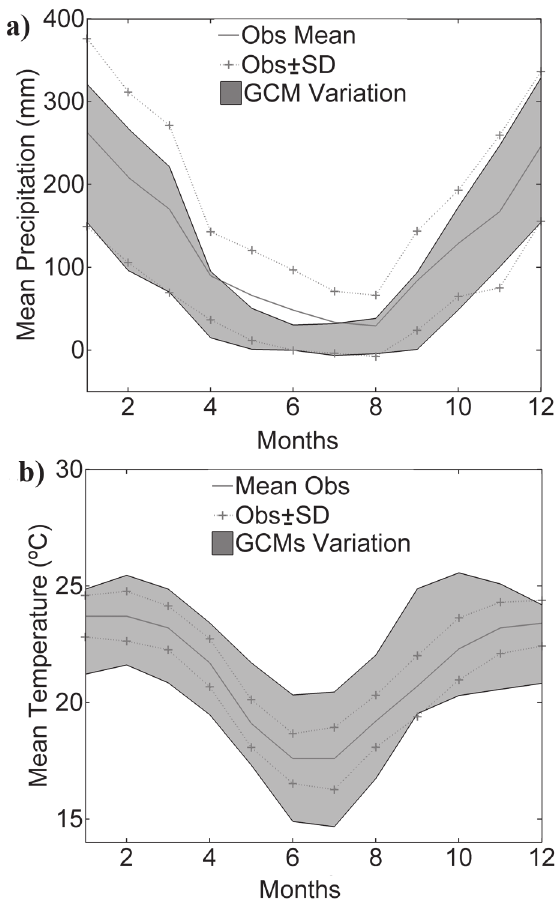
Figure 4 - Long term monthly means of observed (red lines) and simulated (grey envelope) precipitation (1971-1999) (a) and temperature (1974-1999) (b)